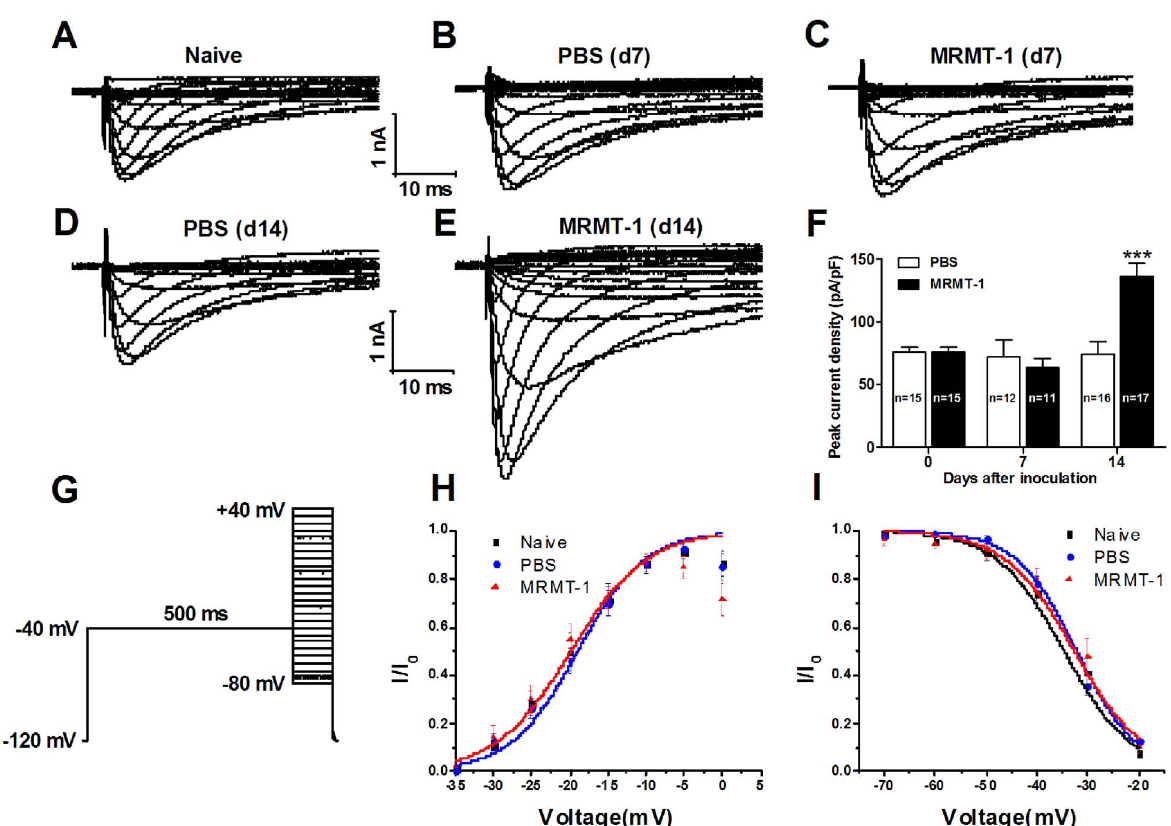
Fig. 2. Nav1.8-mediated sodium current recorded on acutely isolated DRG neurons in naı¨ve, PBS-treated and MRMT-1-treated rats. (A to E): Representative traces of Nav1.8-mediated sodium current in naı¨ve (A), PBS- (B and D) and MRMT-1-treated (C and E) rats, recorded on DRG neurons at 7 (B and C) and 14 (D and E) days after the inoculation of tumor cells or PBS. (F): Statistical analysis of the peak current density. Note that the density of Nav1.8-mediated sodium current is significantly increased in the DRG neurons of bone cancer rats. *** P , 0.001, compared to PBS group, two-way ANOVA, n 5 17 (MRMT-1) and 16 (PBS). (G): Voltage protocol used for recording Nav1.8-mediated sodium currents with 300 nM TTX in the bath solution. A 500-ms pre-pulse at 2 40 mV was used to inactivate Nav1.9 sodium channels. (H and I): Activation and inactivation curves of Nav1.8-mediated sodium current in naı¨ve, PBS-treated and MRMT-1-treated rats at 14 days after the inoculation of tumor cells or PBS. Note that no significant alteration is observed either on the activation (H) or on the inactivation (I) curves among the three groups. Activation curves were fitted using the same protocol used for the recording of Nav1.8 sodium current. Note that the curves in Naı¨ve and PBS groups overlap almost completely. The inactivation curves were fitted using the protocol described in the